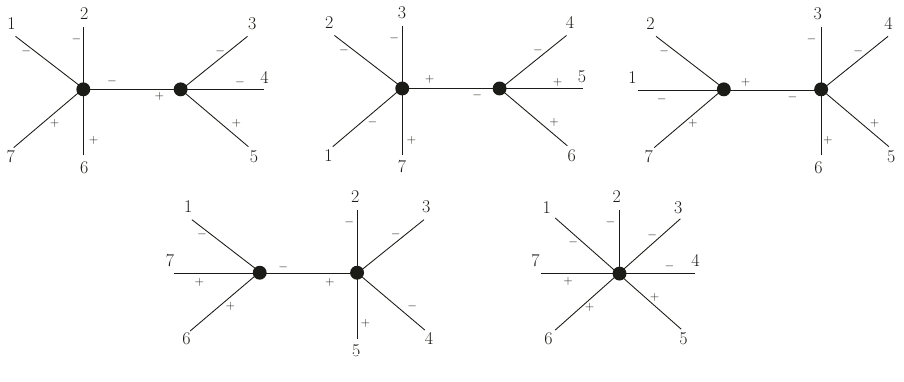
Figure 6 . Diagrams contributing to the 7-point NNMHV amplitude ( − − − − + + +) .